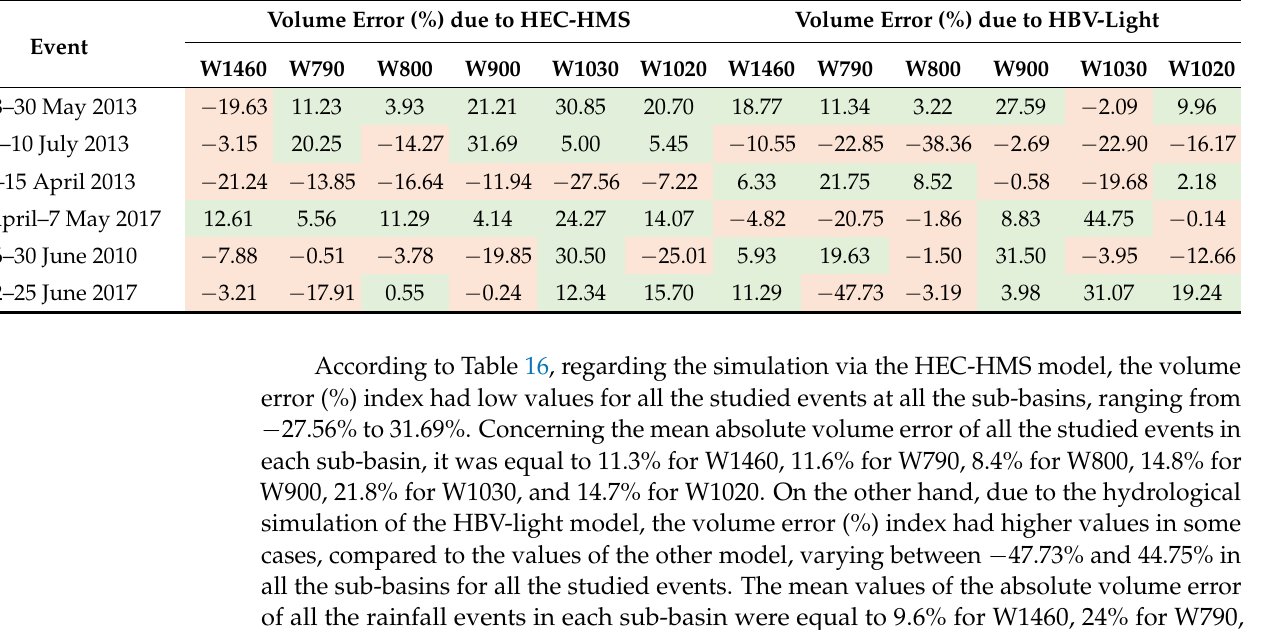
Figure 8. Precipitation, observed and modeled discharge of the 22 – 25 June 2017 rain event at the six gauged stations.